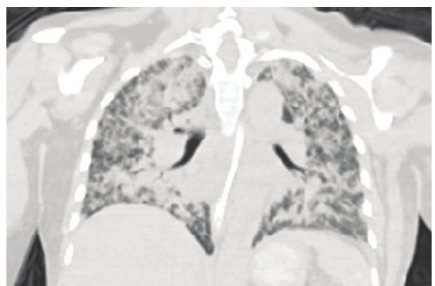
Figure 1: CT thorax demonstrating diffuse airspace opacities involving bilateral lung fields.